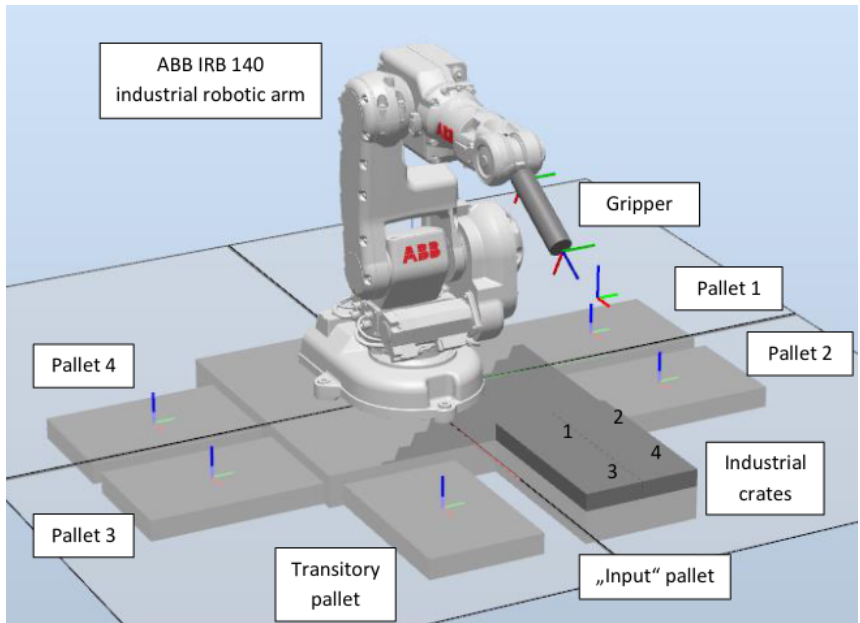
Figure 6. System setup and the layout in the RobotStudio software environment. After the spatial arrangement of the station elements was established and the algorithm was confirmed in the simulation environment, the system was created in the real world. The physical setup of the system in the laboratory is shown in Figure 7.